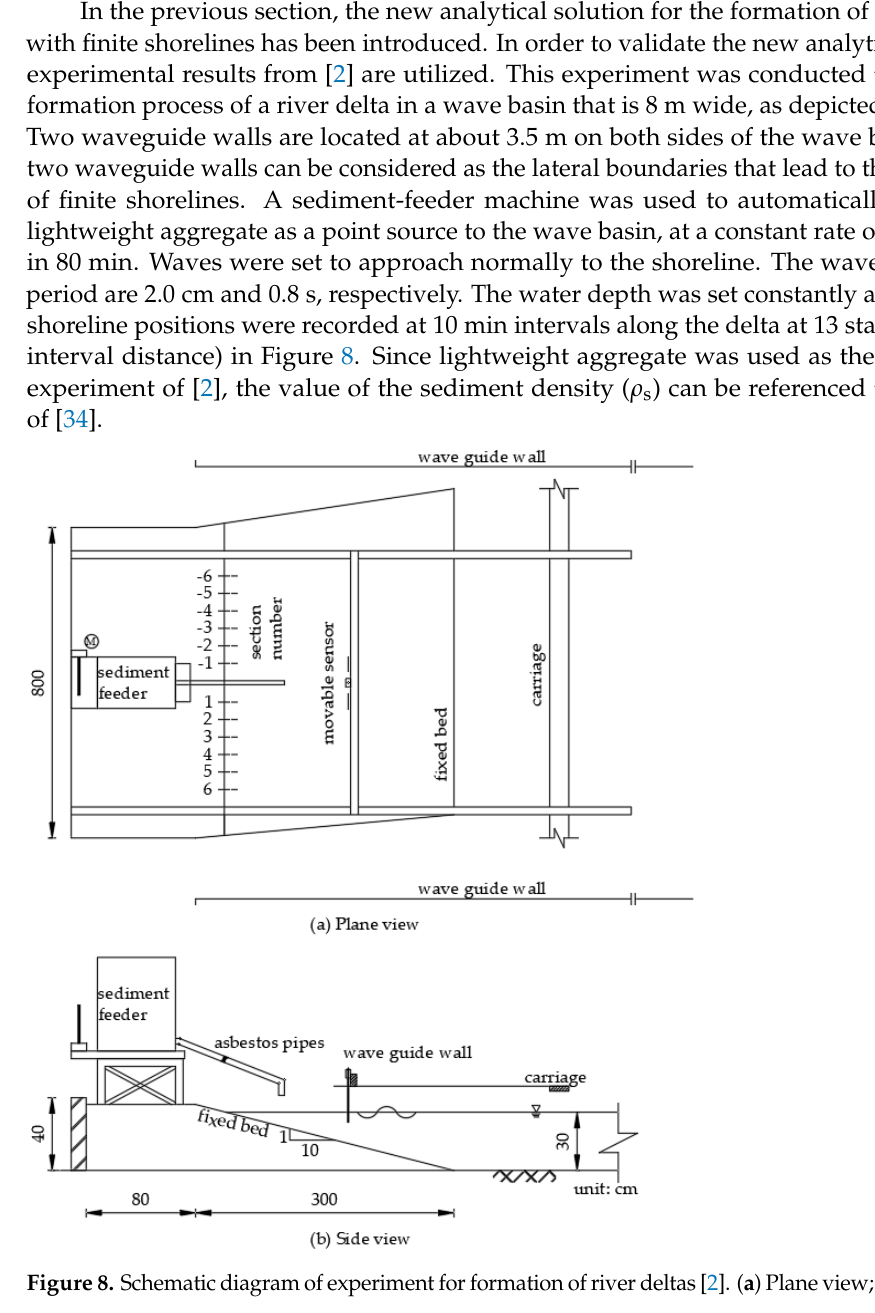
Figure 9. Calibration of ε for the experimental data from the study of [2].